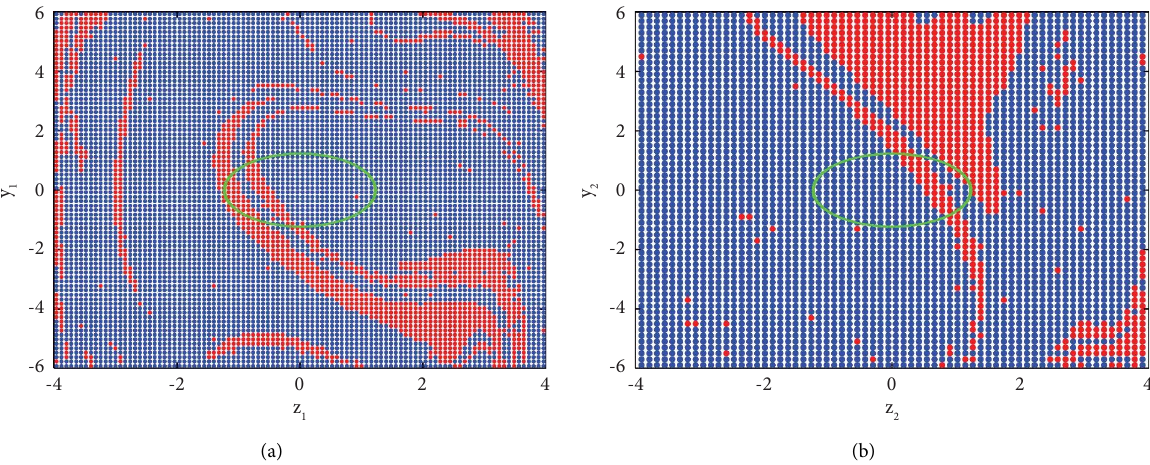
Figure 12: Te target orbit’s positions in the phase space. (a) Te z